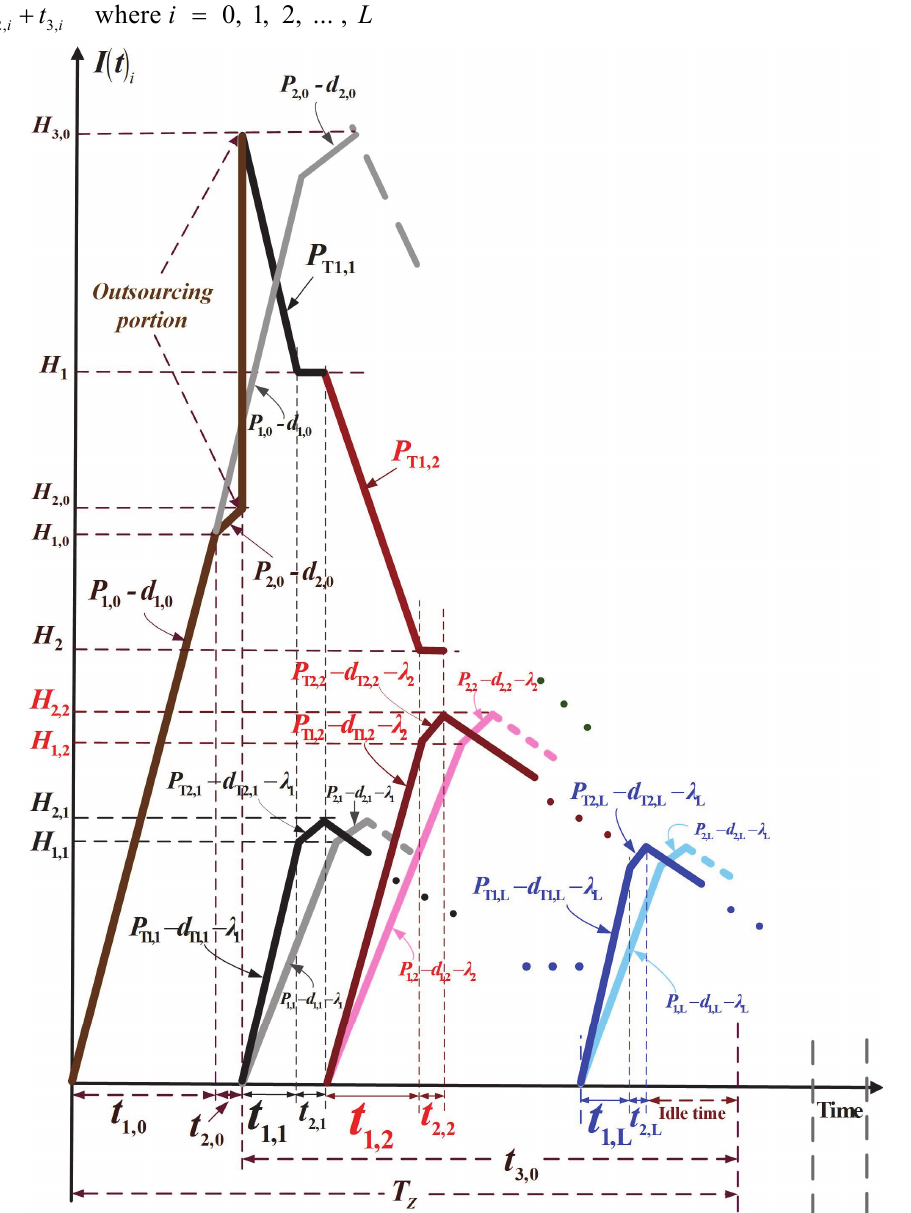
Fig. 1. The inventory status in a replenishment cycle of the proposed model featuring the strategies of outsourcing in stage one, overtime in stage two, and quality reassurance compared to the same model without neither